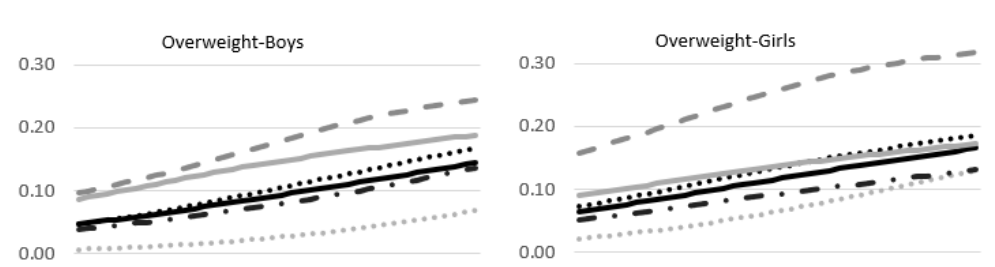
Figure A2. BMI, overweight and obesity evolution by gender and region.